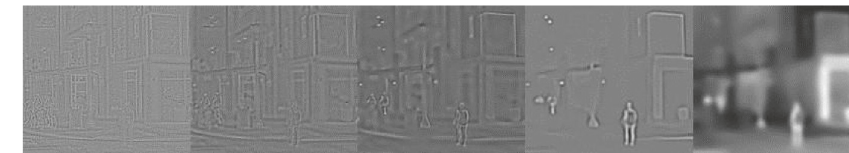
Figure 3: Iterative decomposition with RGF (mean value—guided